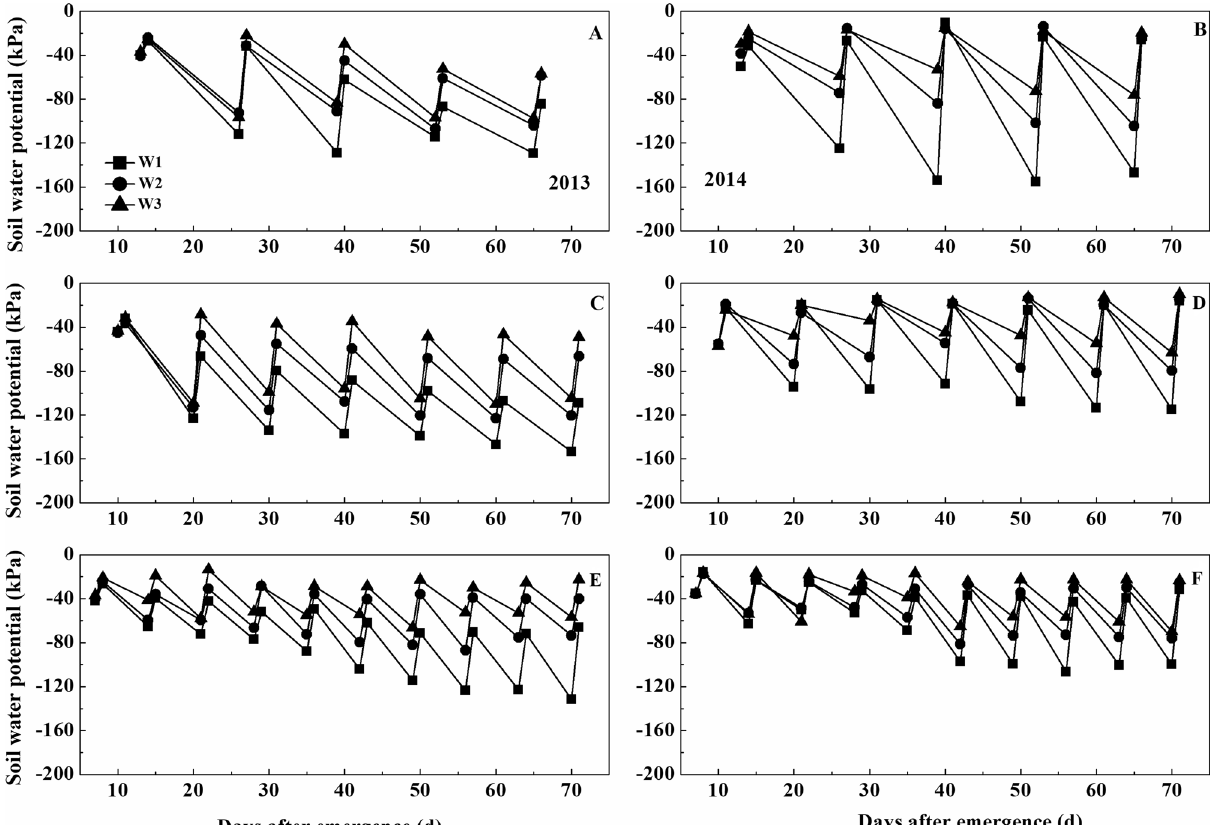
Figure 3. Temporal changes in soil water potential in 20–40 cm depth under ‘Xinchun 6’. ( A ) Soil water potential under D1 treatment in 2013. ( B ) Soil water potential under D1 treatment in 2014. ( C ) Soil water potential under D2 treatment in 2013. ( D ) Soil water potential under D2 treatment in 2014. ( E ) Soil water potential under D3 treatment in 2013. ( F ) Soil water potential under D3 treatment in